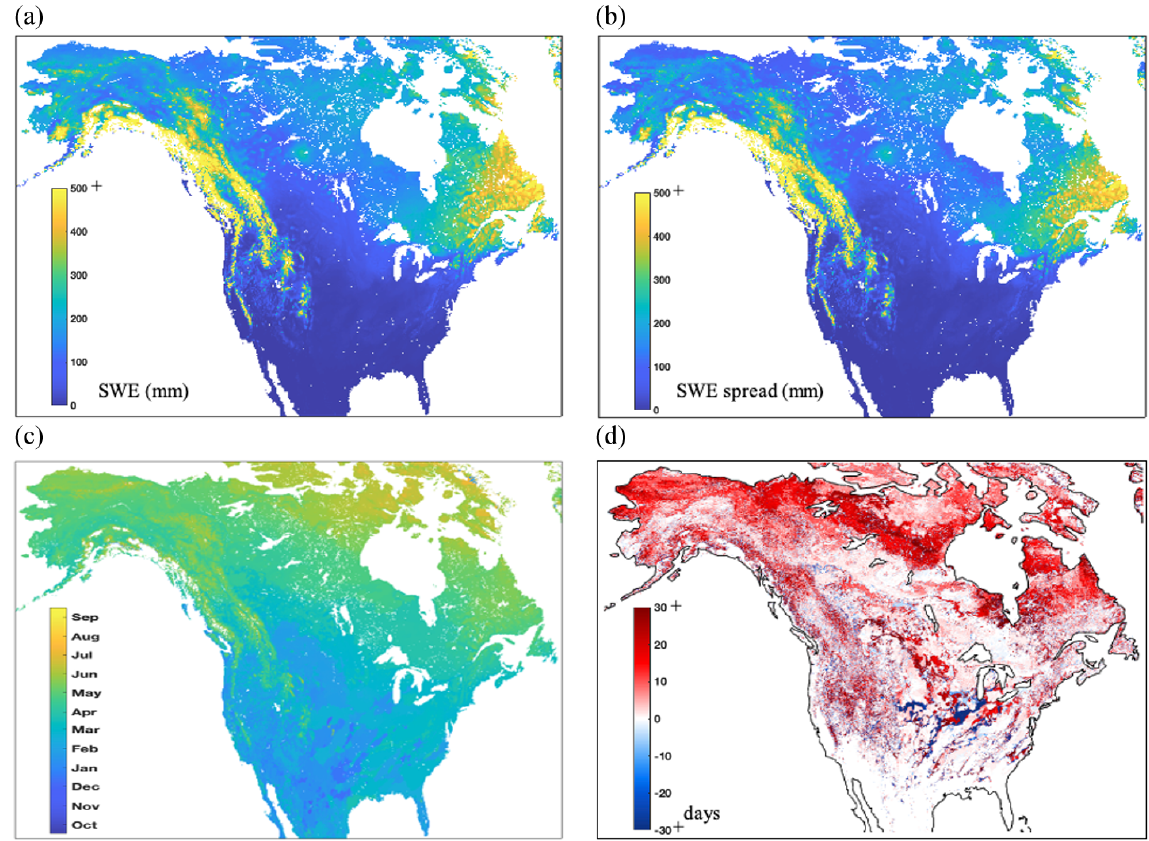
Figure 4. Spatial distributions of (a) the peak SWE amount, (b) the highest SWE spread amount, (c) the average day of year (DOY) with the highest ensemble SWE spread, and (d) the difference of average DOY between the highest ensemble SWE spread and the peak SWE (we are only showing/examining places where the DOY differences exist).